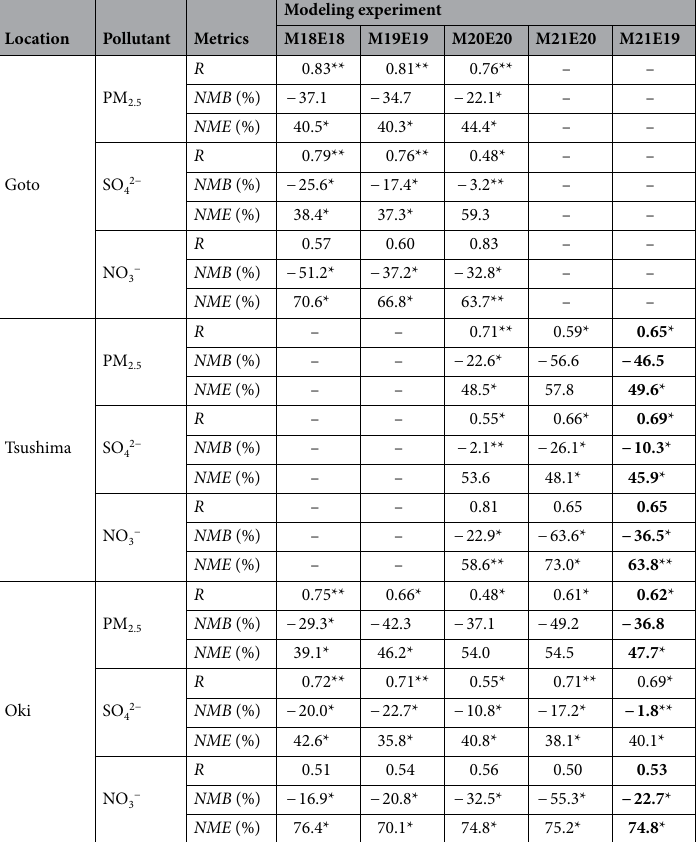
Table 2. Statistical analyses of modeling performance. Notes: for PM 2.5 and SO 4 2− , the model performance goals (marked by **) are R > 0.70, NMB < ± 10% and NME < + 35%, and the model performance criteria (marked by *) are R > 0.4, NMB < ± 30% and NME < + 50%; for NO 3 − , the model performance goals (marked by **) are NMB < ± 15% and NME < + 65%, and the model performance criteria (marked by *) are NMB < ± 65% and NME < + 115% 64 . Where M21E19 is superior to M21E20 in a statistical score, the value is given in bold